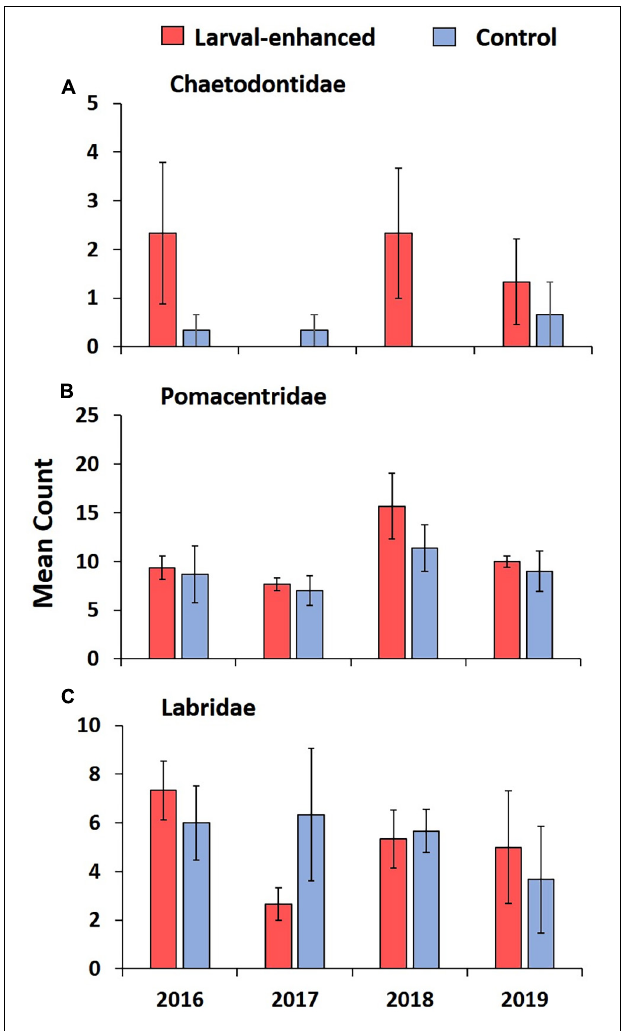
FIGURE 11 | Mean abundance of three commonly occurring fish families (A) Chaetodontidae, (B) Pomacentridae, and (C) Labridae in larval enhanced ( N = 3) and control ( N = 3) plots before the larval restoration experiment in April 2016 and during annual monitoring surveys until 2019. Error bars are ±